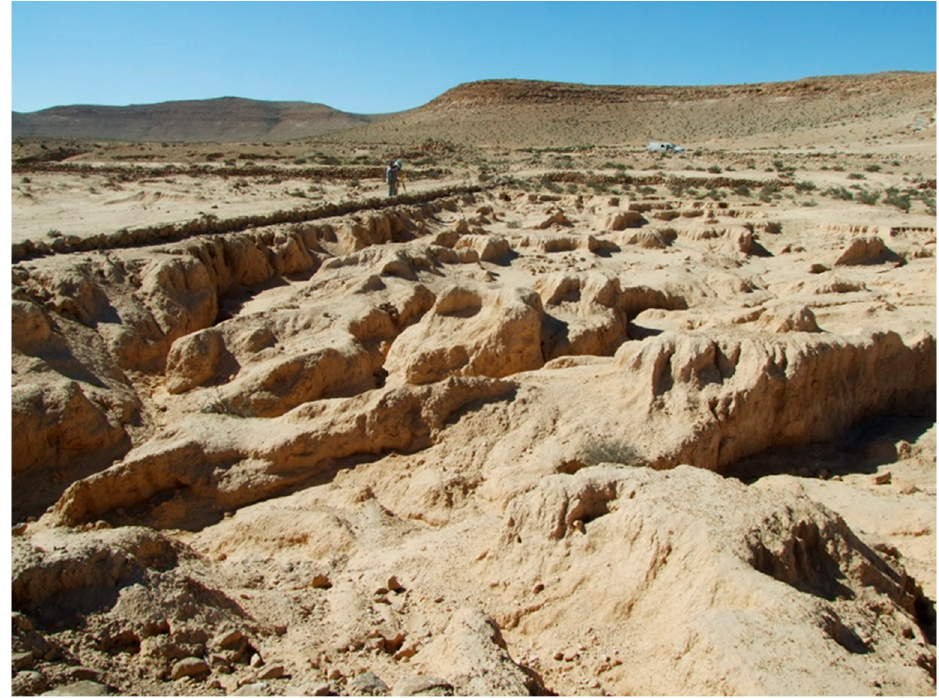
Figure 13. Badlands developed within the Type 2 agricultural plot, Negev Highlands. (Photograph: Y. Avni).